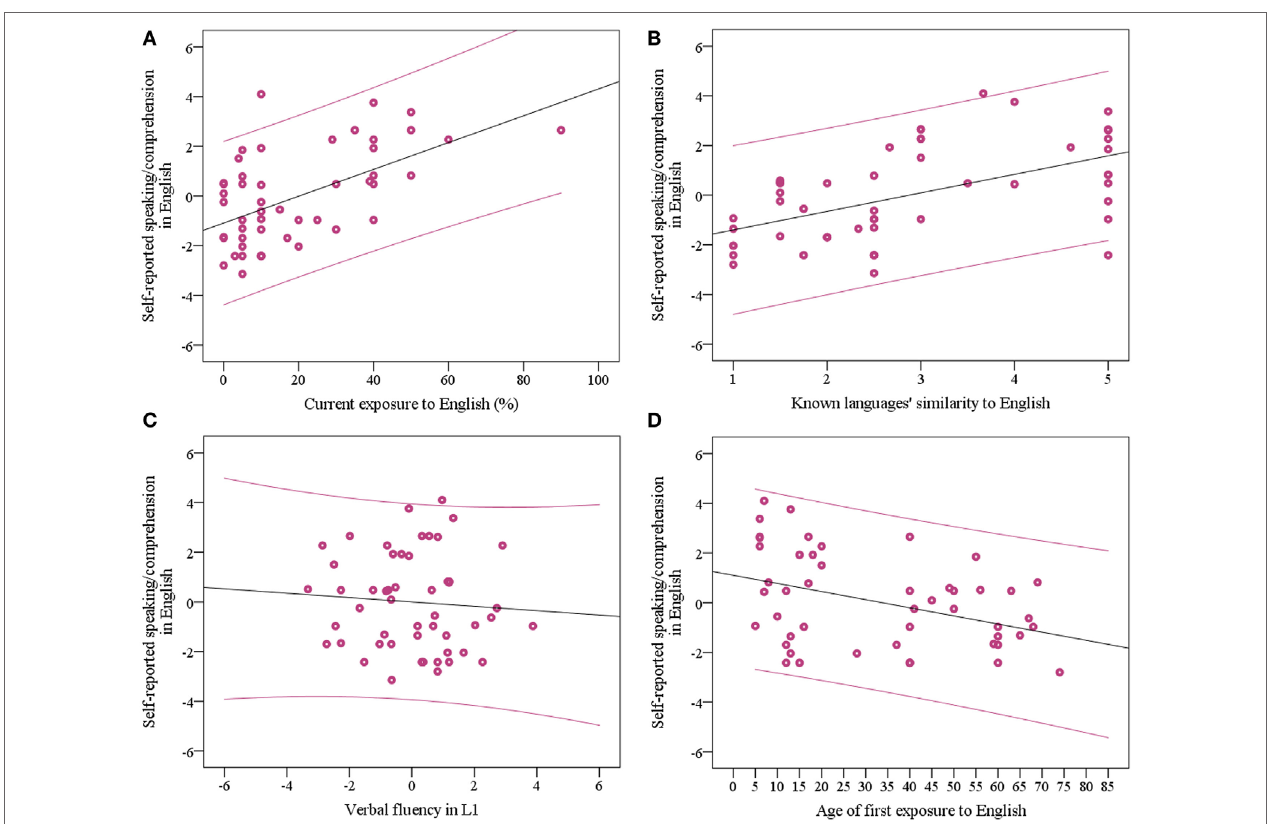
FigUre 3 | Exposure to English (a) , similarity to English of the languages known by participants (b) , verbal fluency in L1 (c) , and age of first English exposure (D) as unique linguistic predictors of the composite self-reported English-speaking and comprehension score. Pairwise correlations are plotted with error lines representing 95% confidence